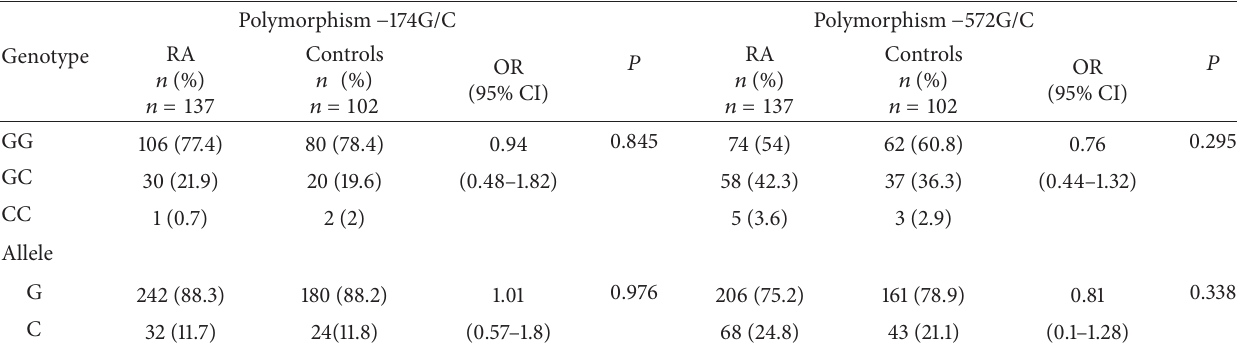
Table 3: Comparison in genotype and allele frequencies of − 174G/C and − 572G/C polymorphisms between the groups with rheumatoid arthritis and